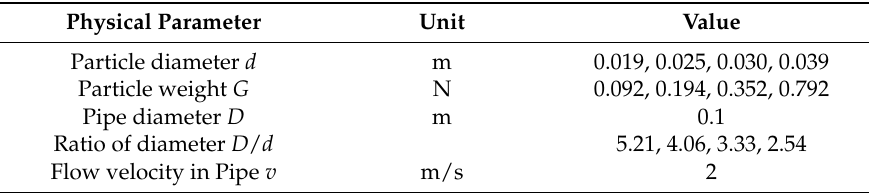
Table 3. Parameters for vertical incipient motion tests of multiple particles.